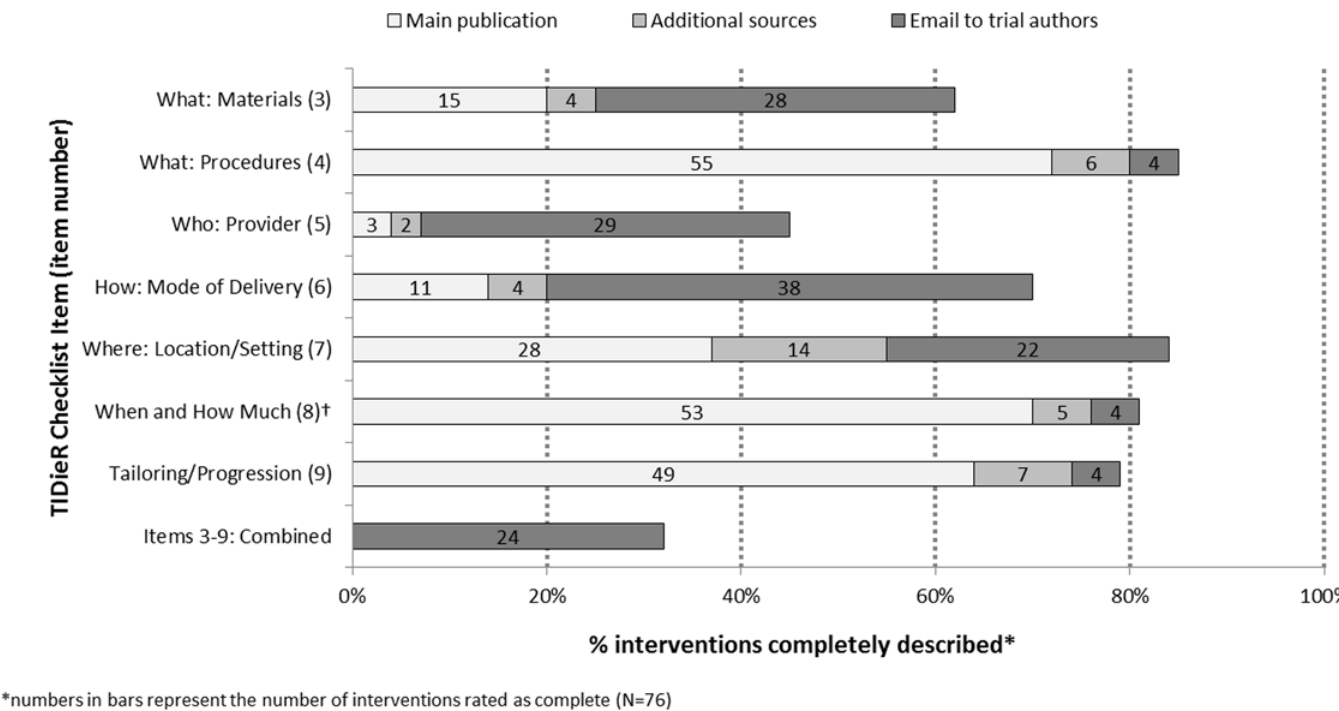
Fig 2. For each Template for Intervention Description and Replication (TIDieR) item, the percentage of interventions which completely reported the item in the main trial publication, after reviewing additional published sources, and after contact with trial